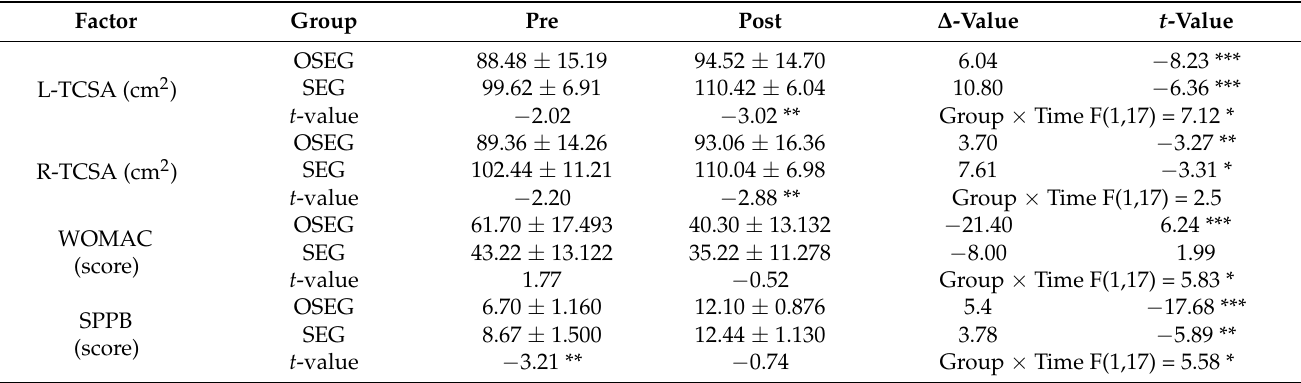
Table 5. Cross-sectional area and physical activity ability